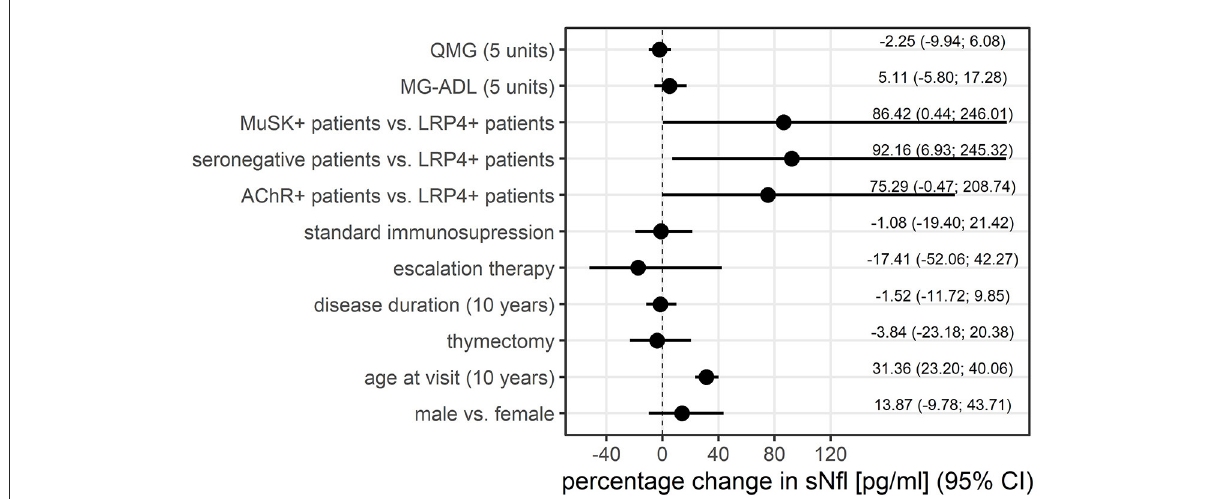
FIGURE3 Association between patient characteristics and sNfl levels, displayed as the percentage change in sNfl, derived from mixed log-linear regression. AChR- + , acetylcholine receptor antibody positive MG-patients, LRP4 + , lipoprotein related peptide 4 positive MG-patients, MG-ADL,